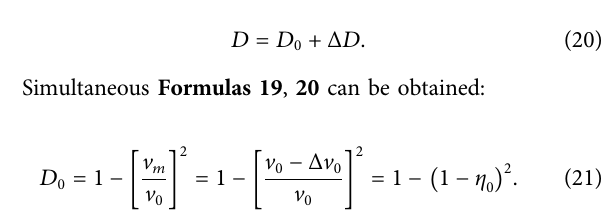
FIGURE13| Cumulativedamageevolutioncurve. (A) 1#Non-linearcumulativedamageevolutioncurveat2.4 mofborehole; (B) 1#Non-linearcumulativedamage evolutioncurveat4.0 mofborehole; (C) 2#Non-linearcumulativedamageevolutioncurveat2.4 mofborehole; (D) 2#Non-linearcumulativedamageevolutioncurveat 4.0 mofborehole; (E) 3#Non-linearcumulativedamageevolutioncurveat2.4 mofborehole; (F) 3#Non-linearcumulativedamageevolutioncurveat4.0 mofborehole.